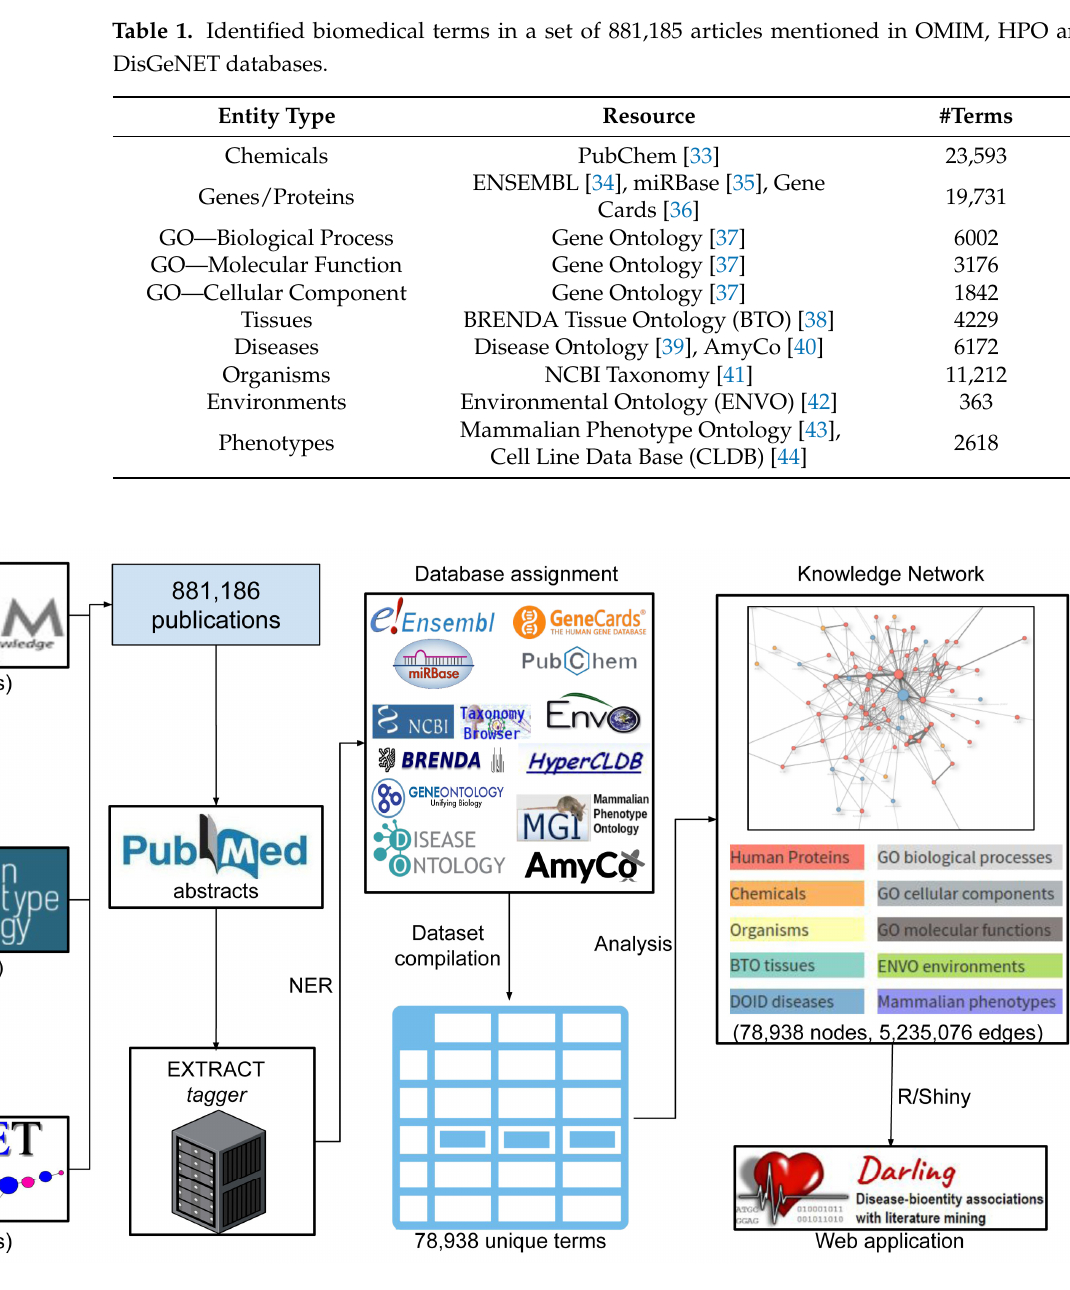
Figure 1. Flowchart of the data retrieval procedure implemented in